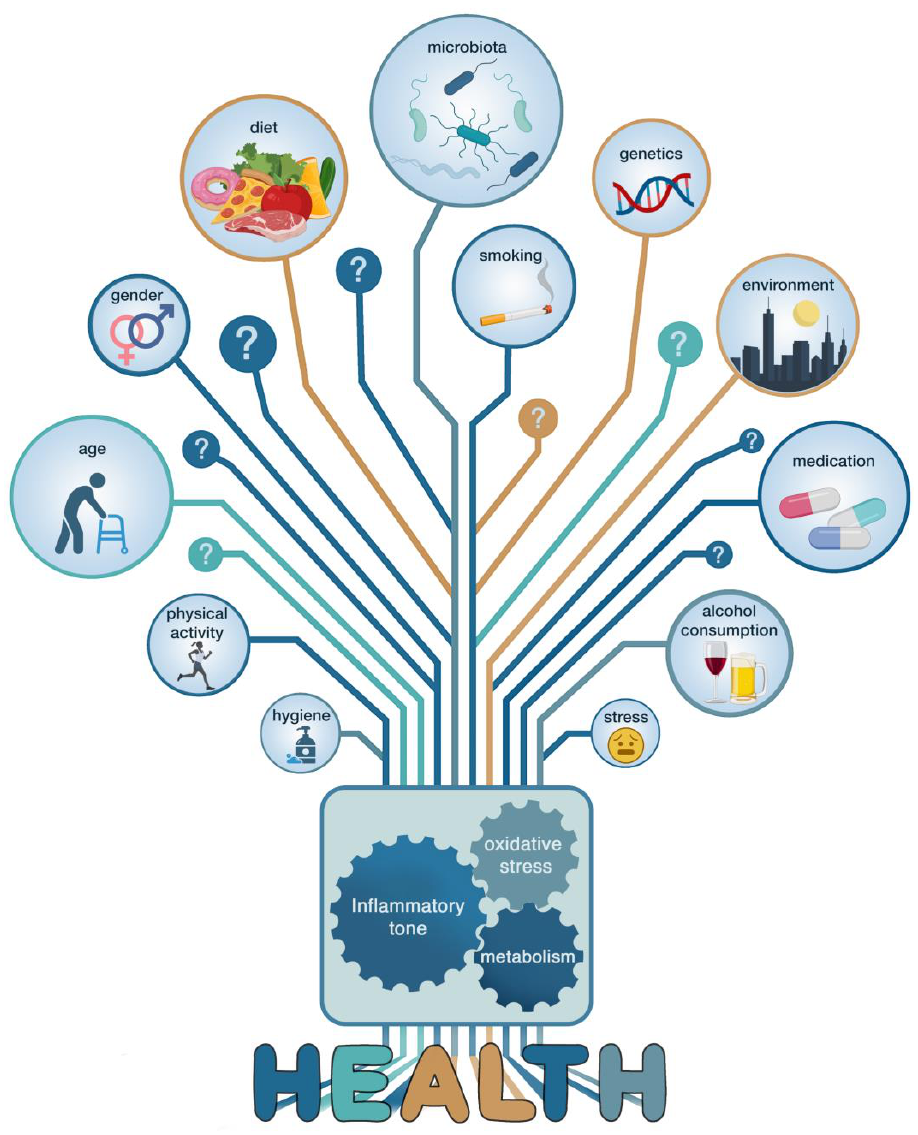
Figure 2. Many factors determine human health. Host characteristics and environmental factors interact and interfere with metabolic, inflammatory and oxidative stress pathways via direct and indirect mechanisms. Untangling these complex dynamics and relationship is one of the biggest challenges in understanding how human health is maintained.